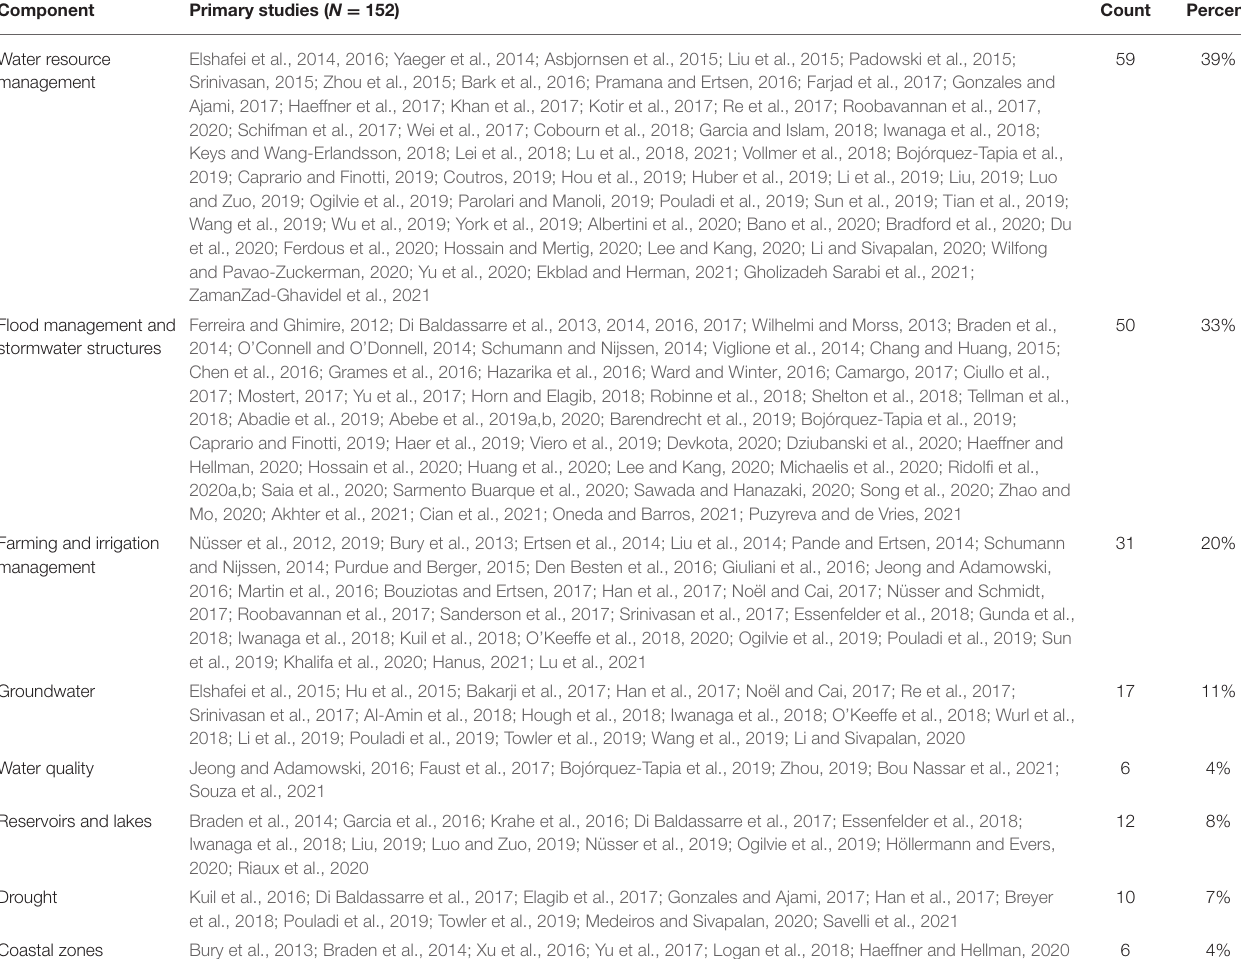
TABLE 3 | The different water components considered in the primary studies along with the source of the study that used each. Component Primary studies ( N = 152) Count